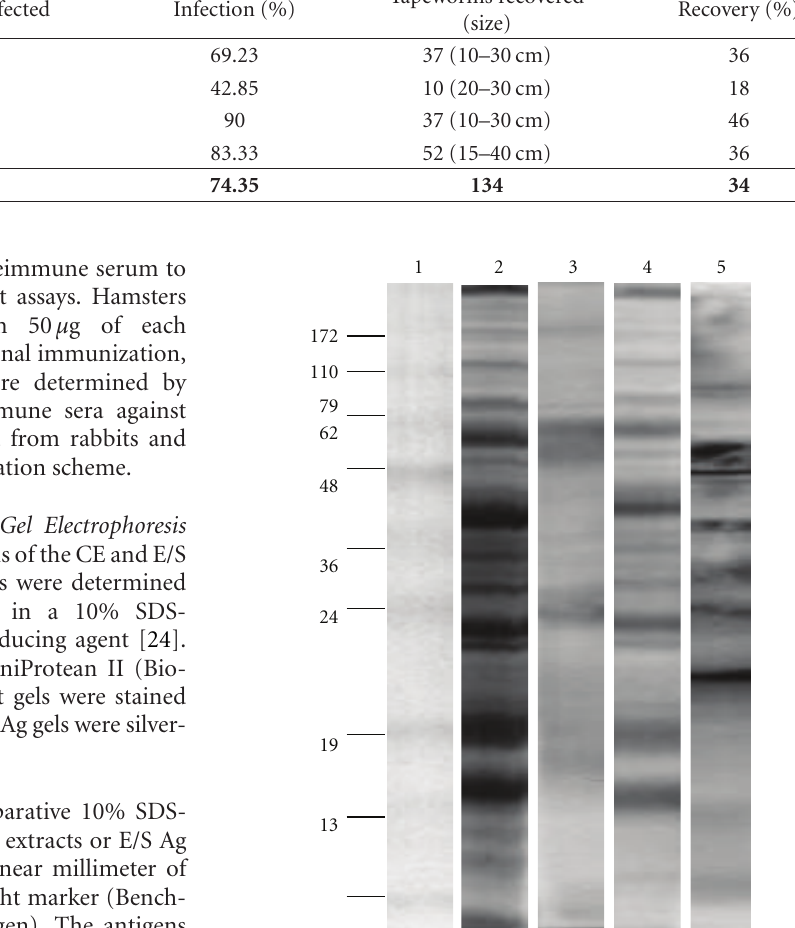
Table 1: Percentages and recovery of Taenia solium tapeworm in immunosuppressed hamsters. Cysticerci lot